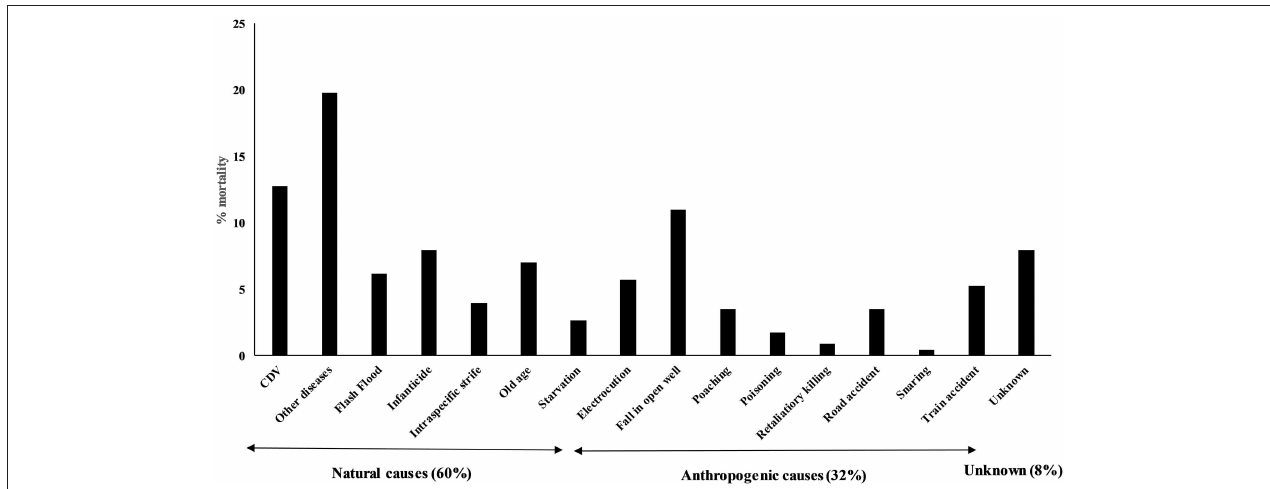
FIGURE 3 | Causes of mortality among free-ranging Asiatic lions ( n = 288). Lions primarily died because of natural causes (60%), while anthropogenic reasons for mortalities (32%) were substantial. Among the natural deaths, 33% were due to canine distemper virus and other diseases.